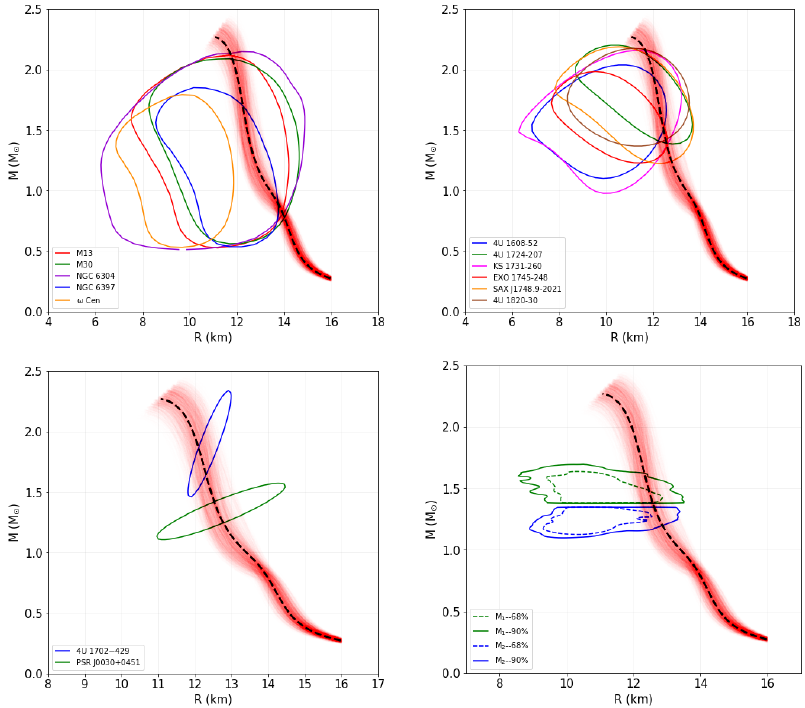
Figure 2. Mass–radius relations corresponding to the EOS parameters within the 68% CI in the case of Gaussian prior in comparison with the astrophysical observations. The black lines correspond to the most probable parameter